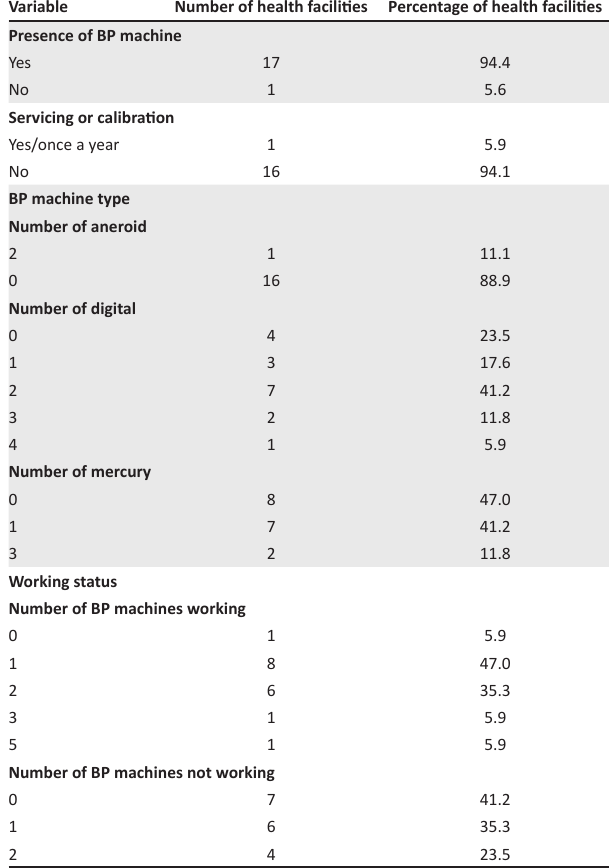
TABLE 1: Availability and functionality of blood pressure machines within health facilities. Variable